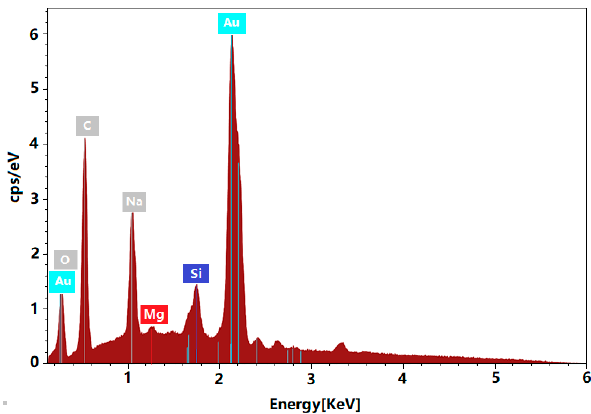
Figure 2. Energy-dispersive spectroscopy (EDS) spectra of the fabricated AuNPs obtained from C. sinensis peel at pH = 11.